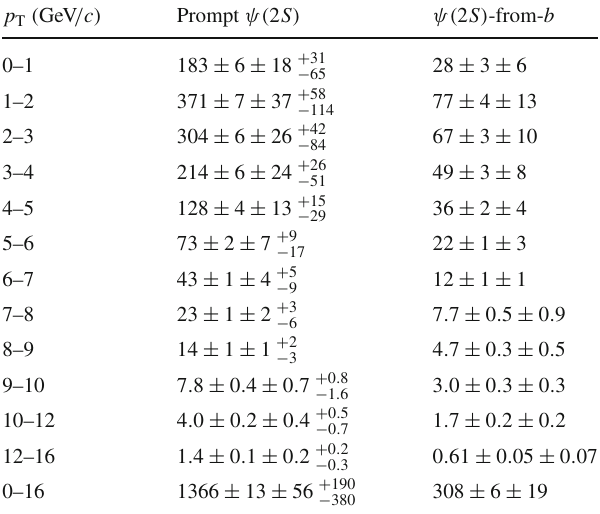
Table 2 Differential cross-sections d σ/ d p T (in nb/(GeV / c )) of prompt √ ψ( 2 S ) and ψ( 2 S ) -from- b hadrons at s = 7TeV, integrated over y between 2.0 and 4.5. The first uncertainty is statistical and the second systematic. The third asymmetric uncertainty for the prompt ψ( 2 S ) mesons is due to the unknown polarisation p T (GeV / c